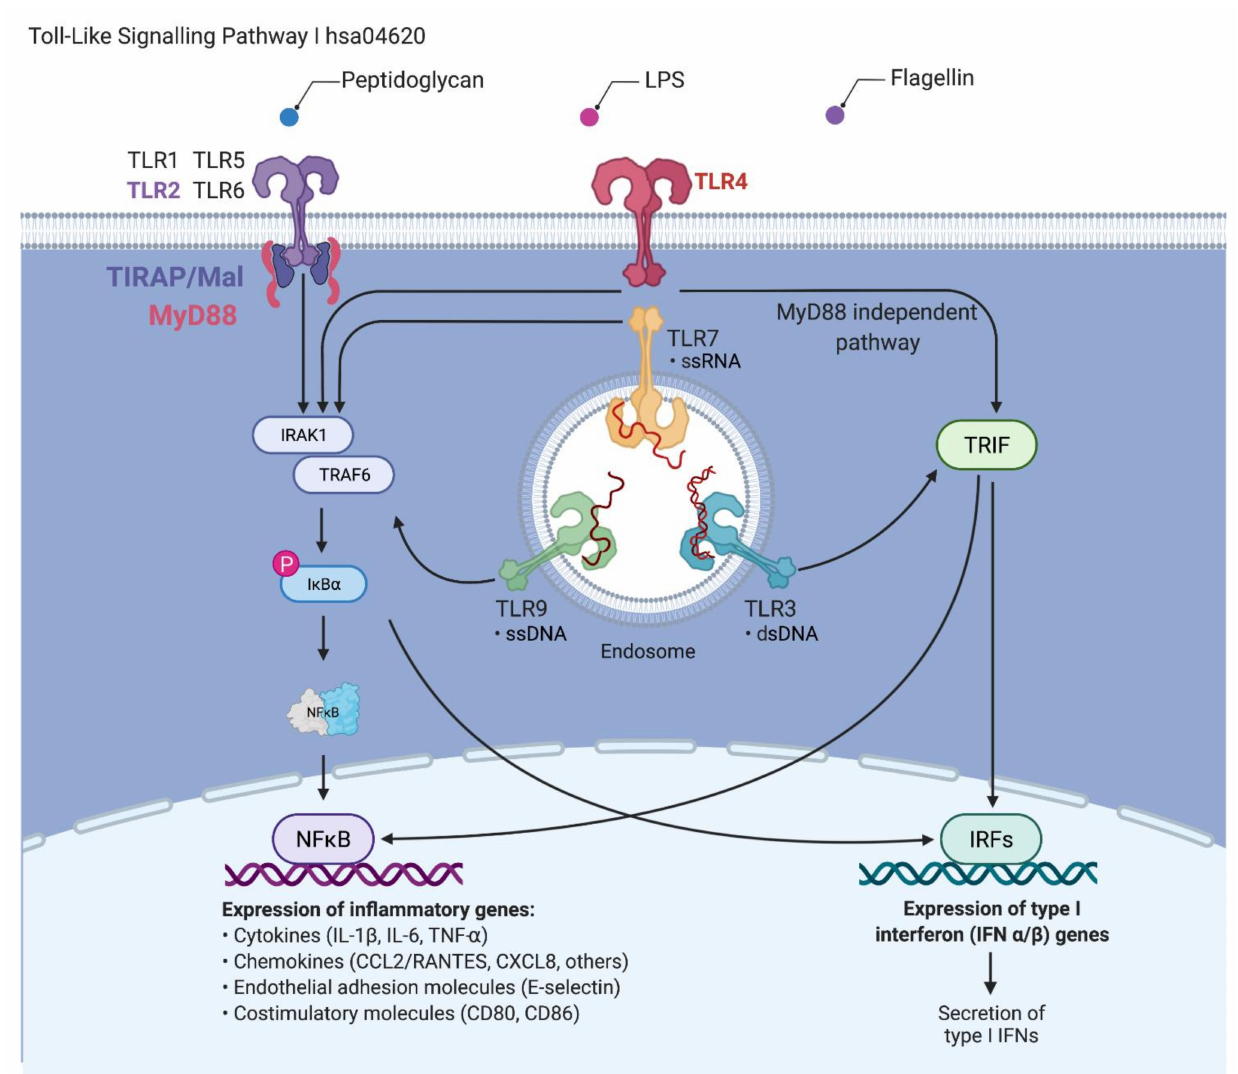
Figure 1. The signaling pathway of Toll-like receptors (TLRs). Upon contact with pathogens that secrete pathogen-associated molecular patterns, their recognition is initiated via pattern recogni- tion receptors, including TLRs. These receptors trigger innate immune responses via the MyD88- dependent pathway, leading to the production of proinflammatory cytokines with activation of nuclear factor kappa B (NF κ B) and downstream gene targets [37,38]. The MyD88-independent pathway associated with the induction of type I interferon (IFN) and IFN-inducible genes. (Data source: KEGG pathway, hsa04620 and compiled in Biorender.com (Accessed on 18 December 2021). Adapted from “TLR Signaling Pathway”, by BioRender.com (2021). Retrieved from